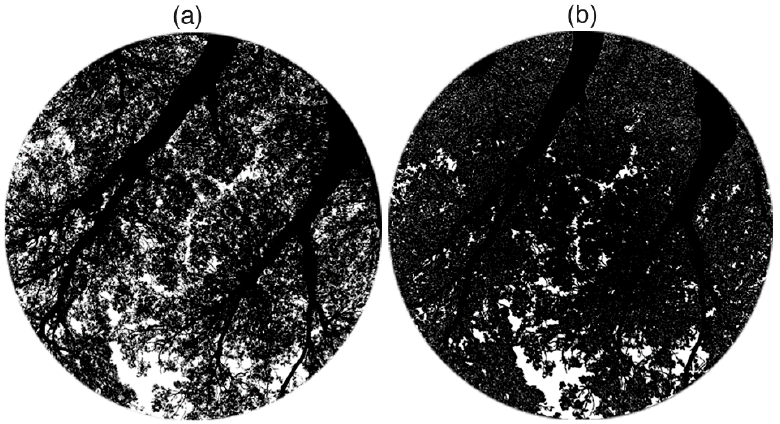
Figure 6. Actual HI ( a ) and TLS-SHI from TLS data ( b ).